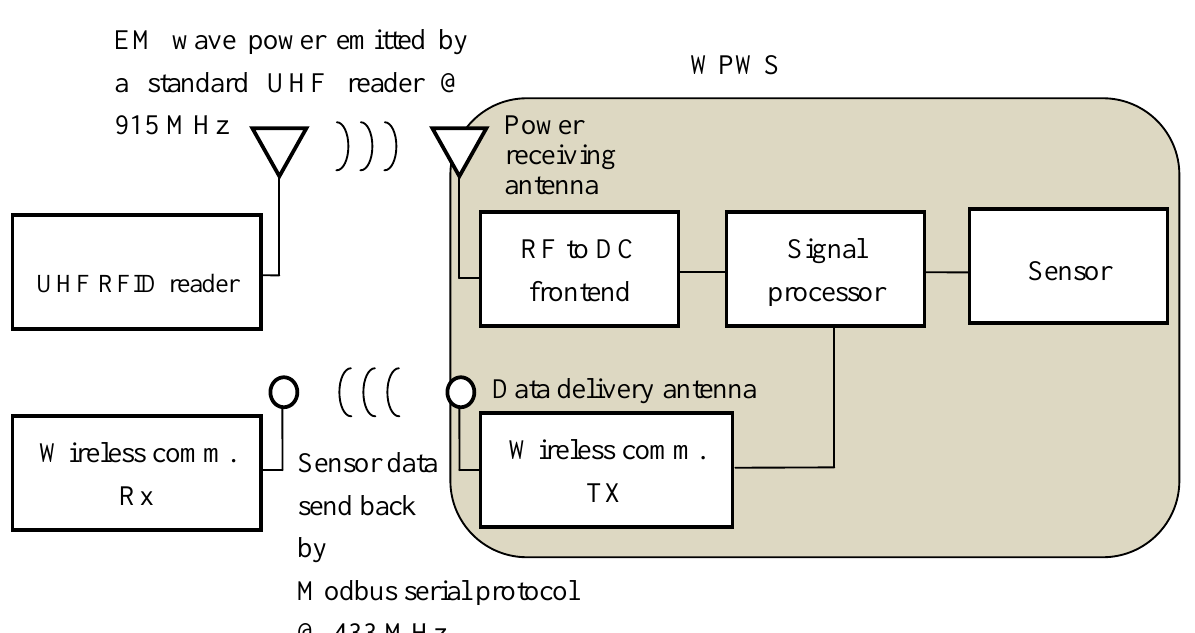
Figure 1. Dual antenna structure of a wireless powered wireless sensor